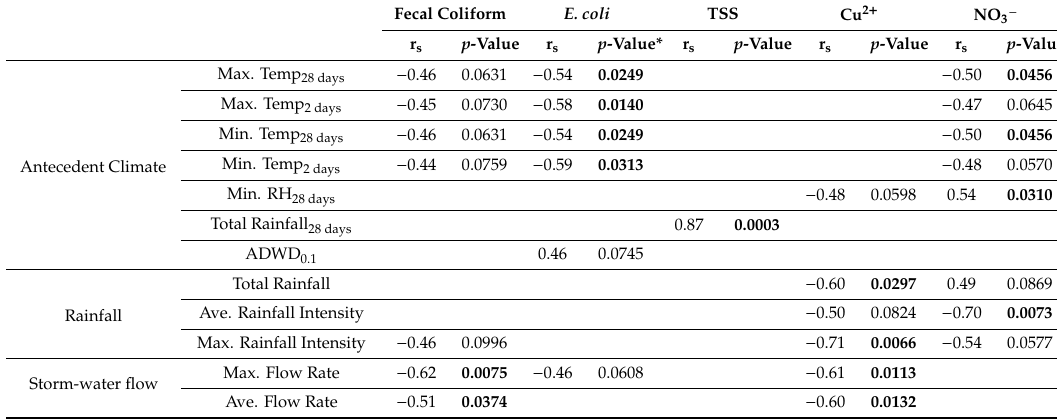
Table 4. Spearman rank correlation analysis between flow, rainfall, and antecedent climate explanatory variables and